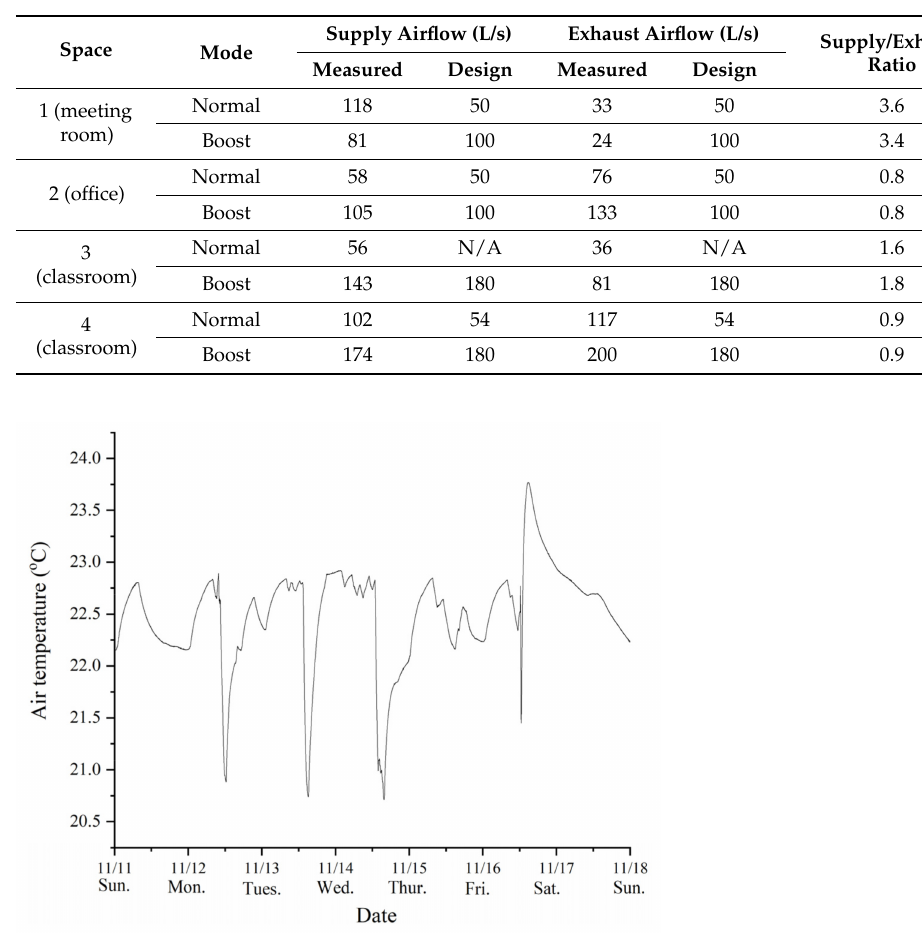
Figure 6. Room air temperature of Space 1 (meeting room) under the normal operation mode.